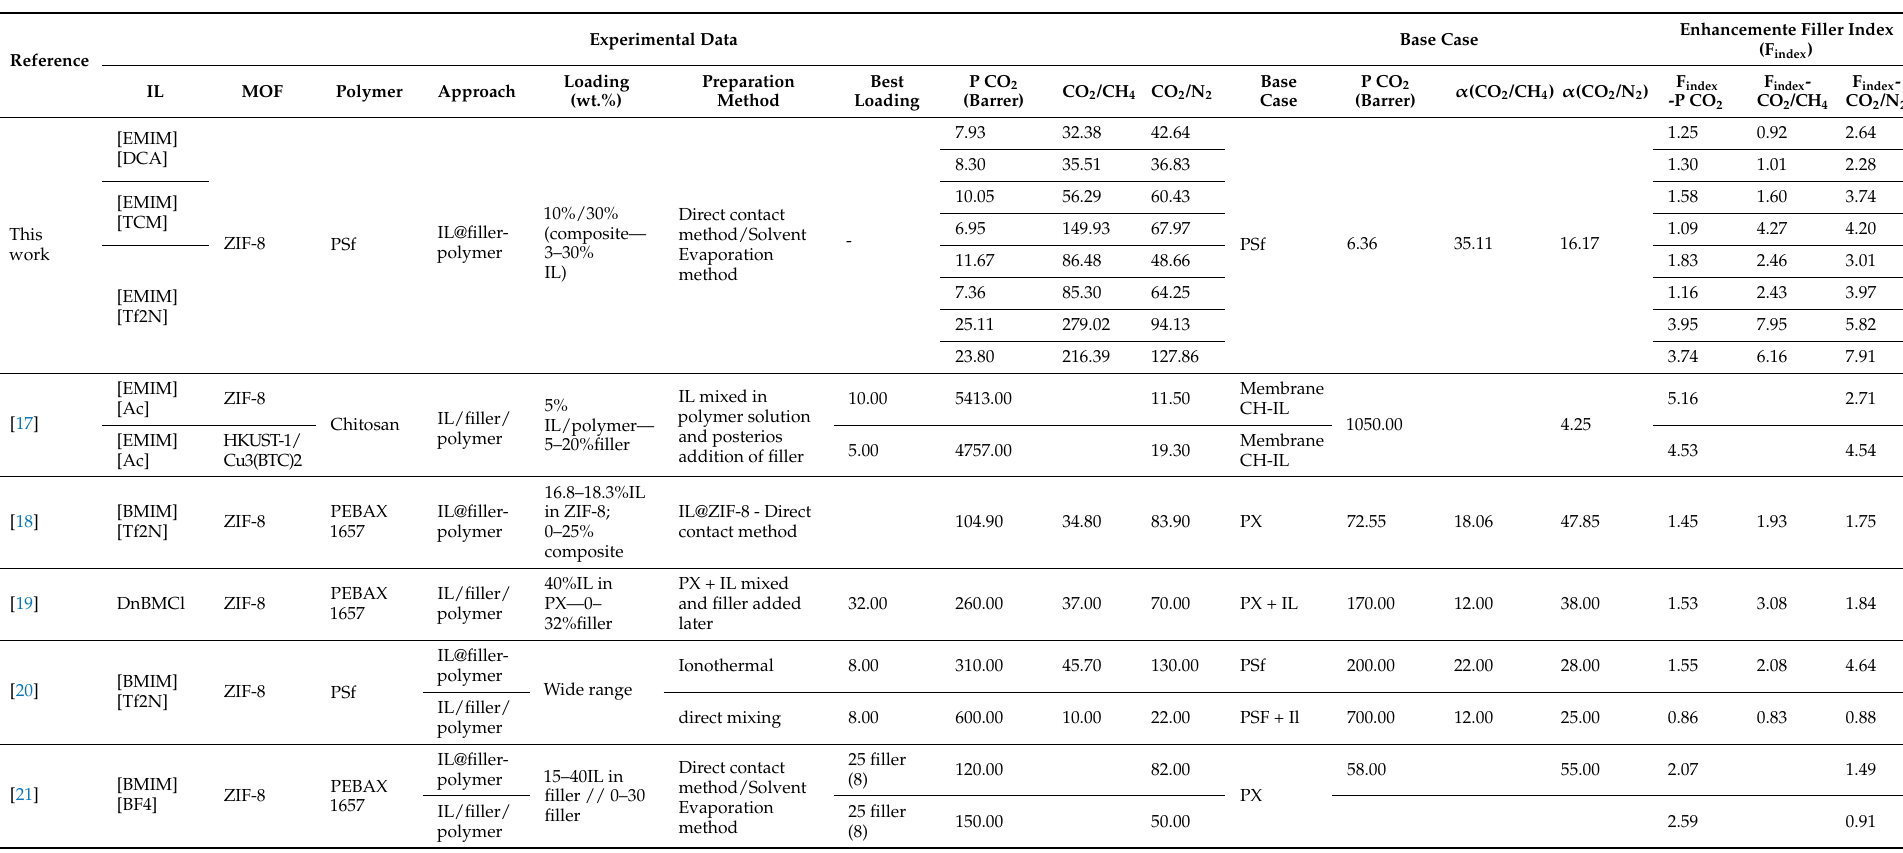
Table A6. MMMs composed by IL/MOF and IL@MOF and base reference data for enhancement filler index (F index ) calculation and calculation of enhancement filler index (F index ) of CO 2 permeability and ideal